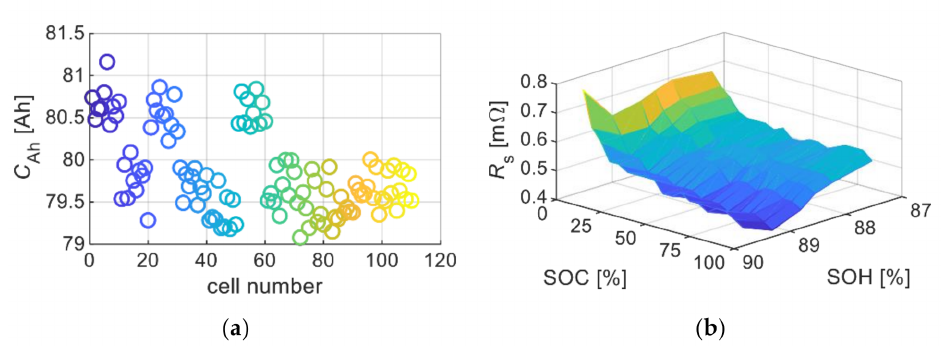
Figure 9. Identification results of the cell parameters: ( a ) C Ah and ( b ) R s